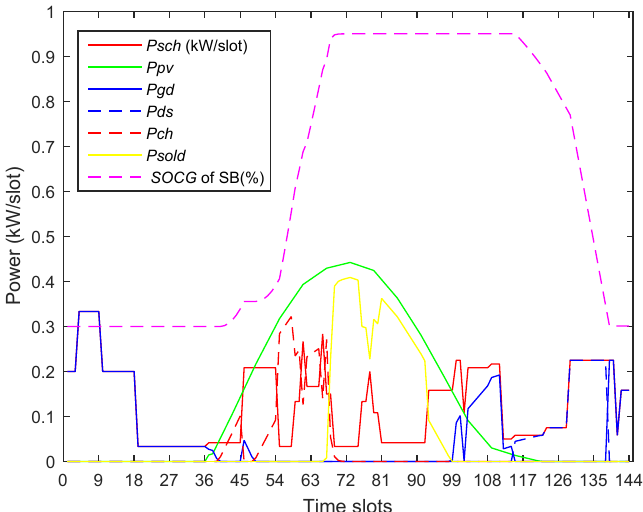
Figure 26. Load profile for maximal reduction in CE using CPP(MS) for PDDR-RED-based